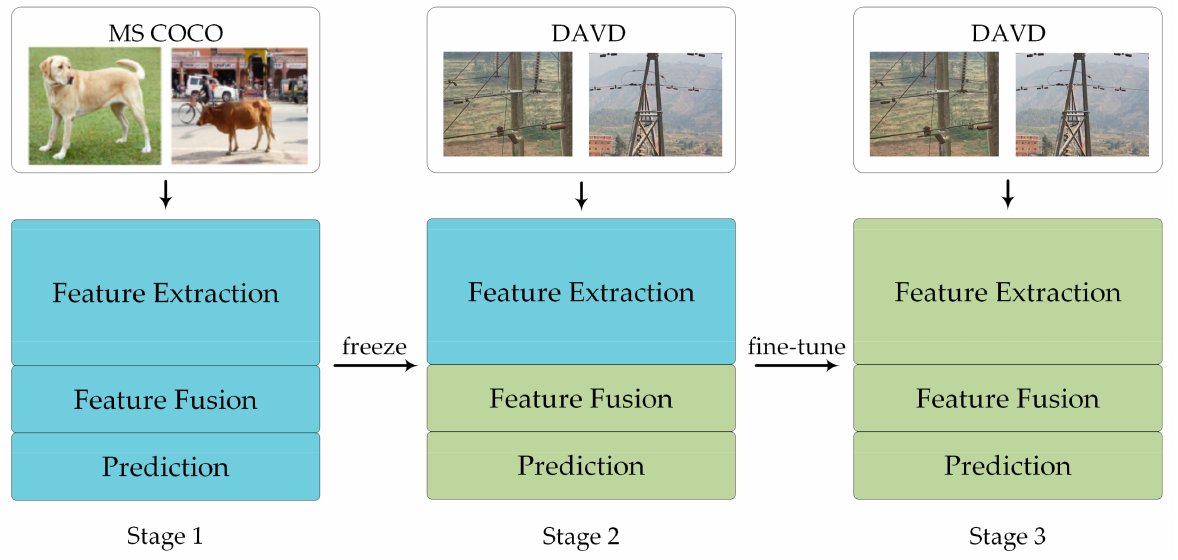
Figure 16. Our multi-stage transfer learning strategy.